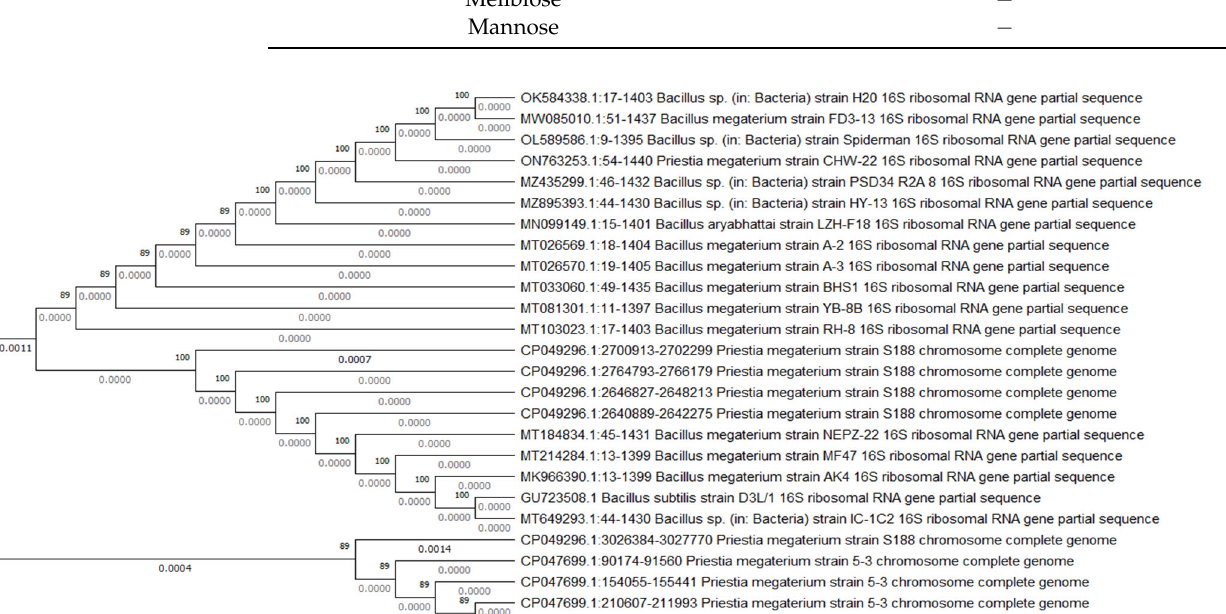
Figure 1. Effect of incubation period for extracellular protease production by selected screened iso ‐ lates from compost soil. ( A ) Bar represents enzyme concentration (U/mL) and ( B ) line graph for bacterial growth (O.D.). The statistical significance was p < 0.05.